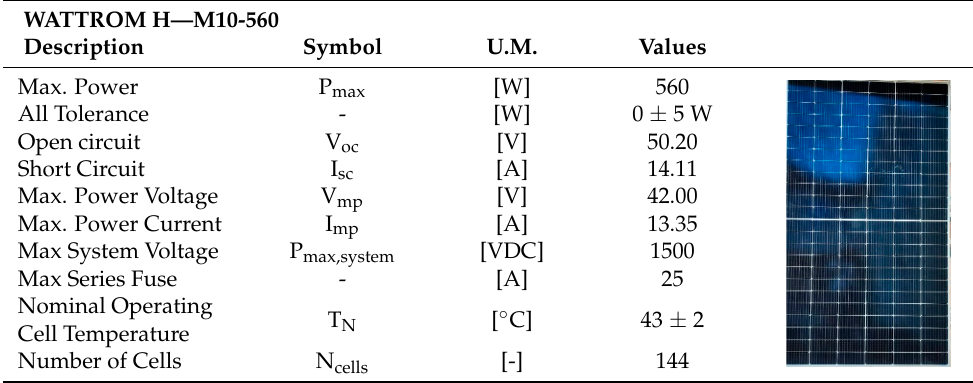
Table 1. Electrical characteristics and performances of the PV module.